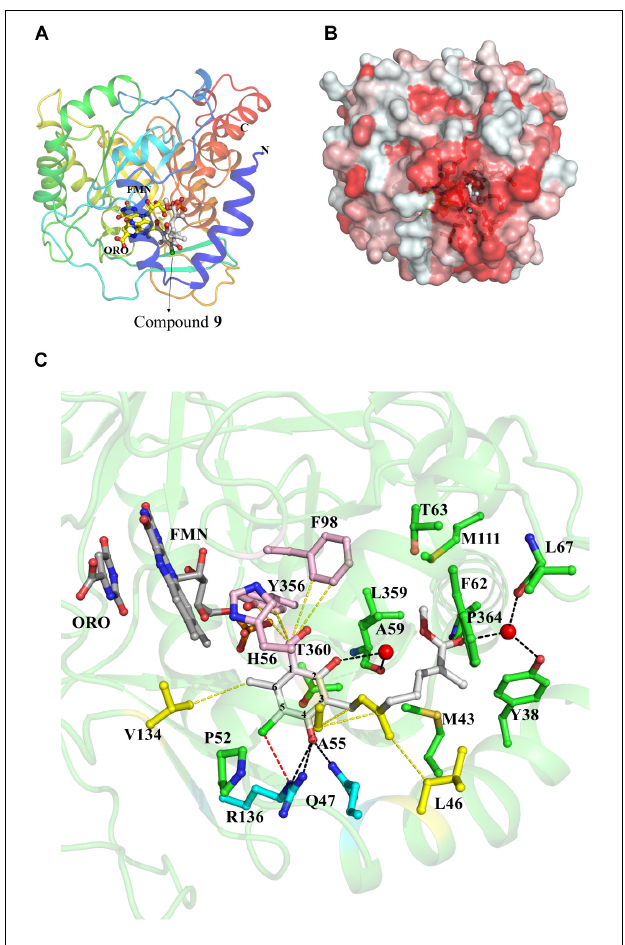
FIGURE 2 | Representative crystal structure of HsDHODH in complex with 1 and its derivatives. (A) Overall structure of HsDHODH in complex with 9 . Cartoon model is colored in rainbow from blue (N terminus) to red (C terminus). FMN and orotate (ORO) molecules are shown in yellow ball and stick models. Compound 9 is shown in white ball and stick model. (B) Surface presentation of HsDHODH in complex with 9 view from the same angle as (A) . Colors are according to the following hydrophobicity scale: red, high hydrophobicity and white, low hydrophobicity (www.pymolwiki.org/index.php/Color_h). (C) Inhibitor binding site of HsDHODH. FMN and orotate (ORO) molecules are shown in gray ball and stick models. Compound 9 is shown in white ball and stick model. The black dashed lines represent hydrogen bonds. The yellow dashed lines represent important hydrophobic interactions. The red dashed line represents halogen bond. Water molecules, which interact with both 9 and HsDHODH through hydrogen bonds, are shown as red